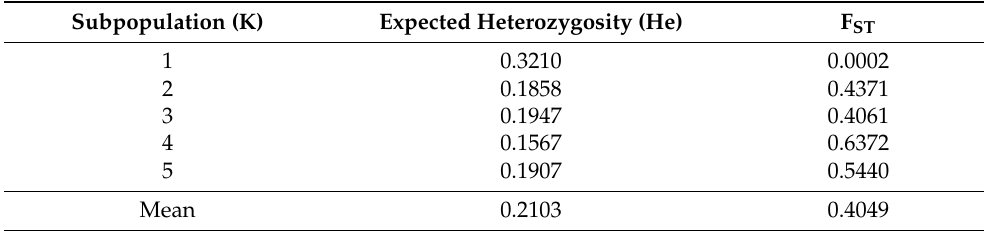
Table 10. Expected heterozygosity (He) and F ST values in four squash subpopulations. Subpopulation